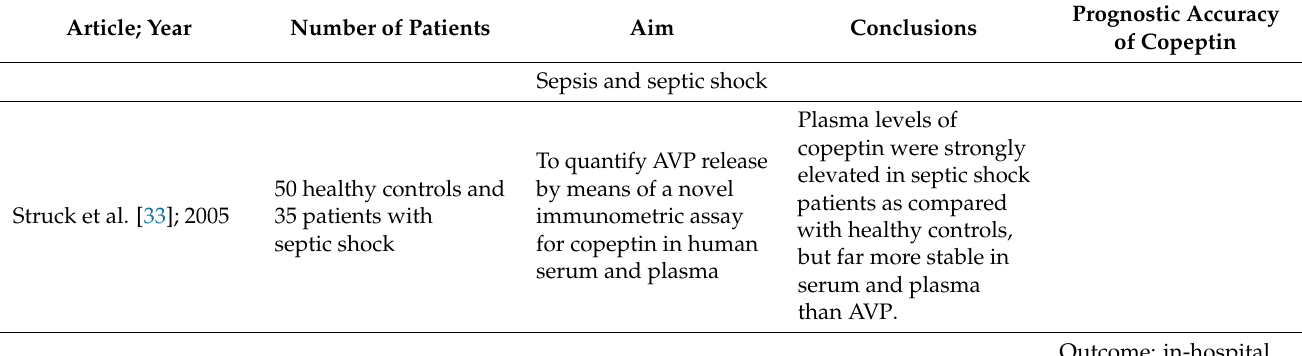
Table 1. Overview of the most important references on copeptin in critically ill